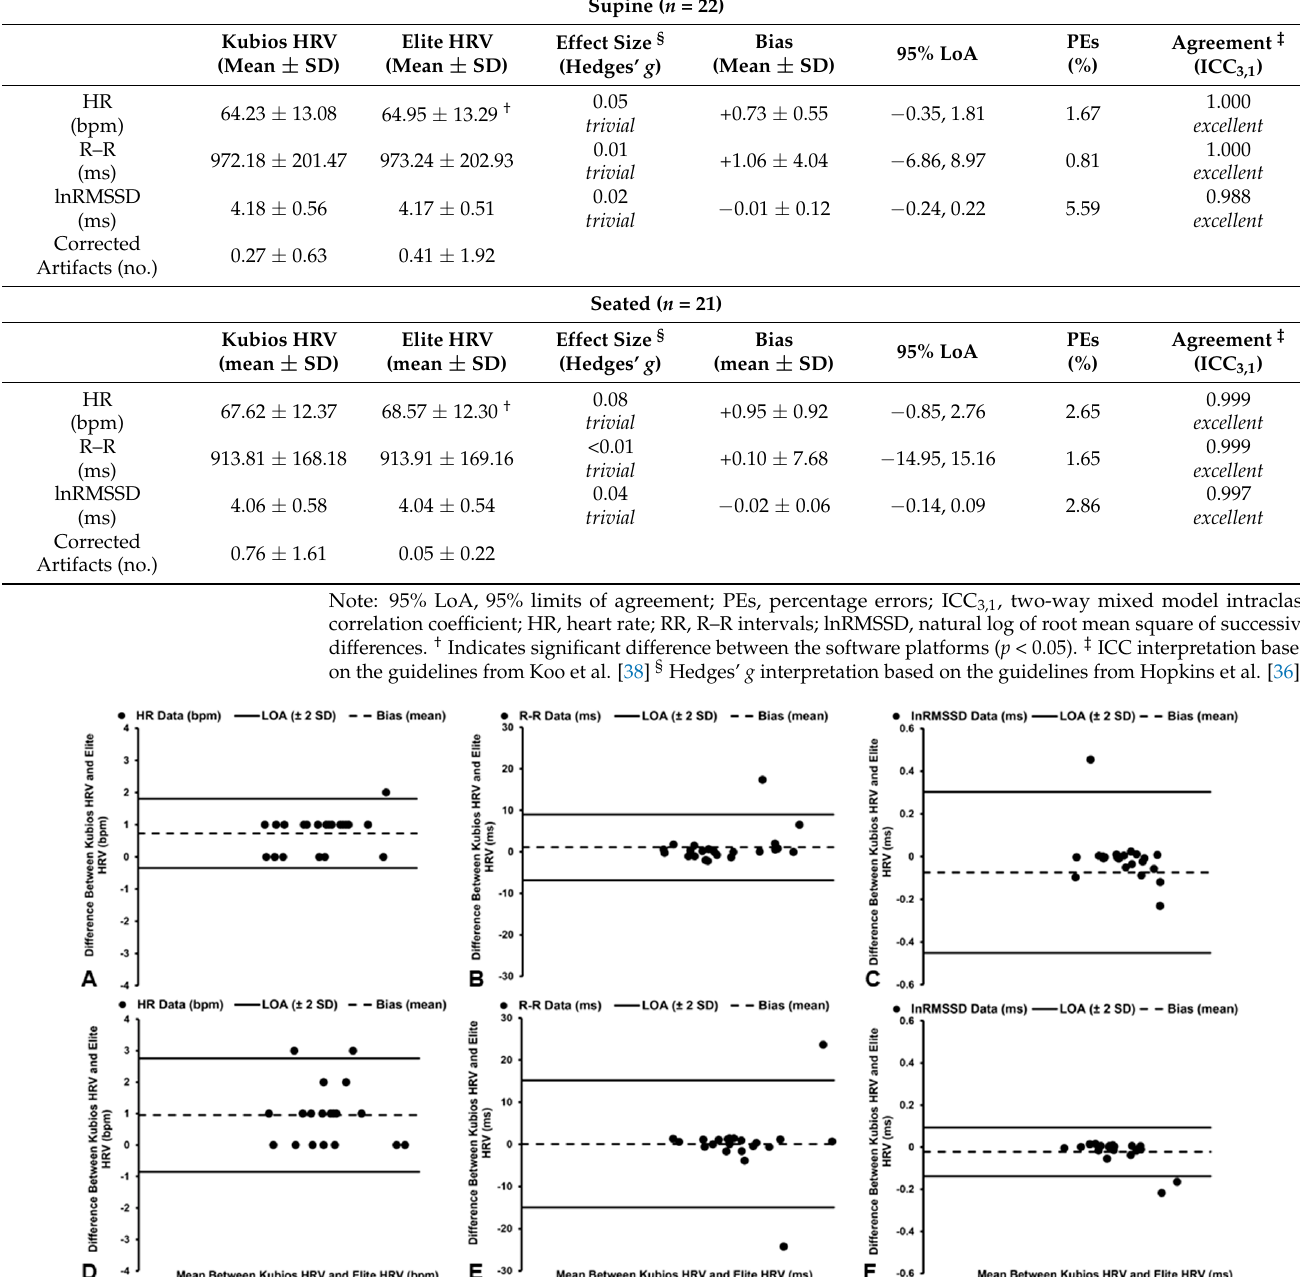
Trivial and nonsignificant ( t 21 = 0.402, p = 0.692) differences in lnRMSSD data were observed between the software platforms (Table 2), with the Elite HRV smartphone ap- plication demonstrating a mean bias of − 0.01 ms and 5.59% PEs (Figure 3C). Excellent agreement (ICC 3,1 = 0.988, [95% CI: 0.970, 0.995]) and a near-perfect relationship were